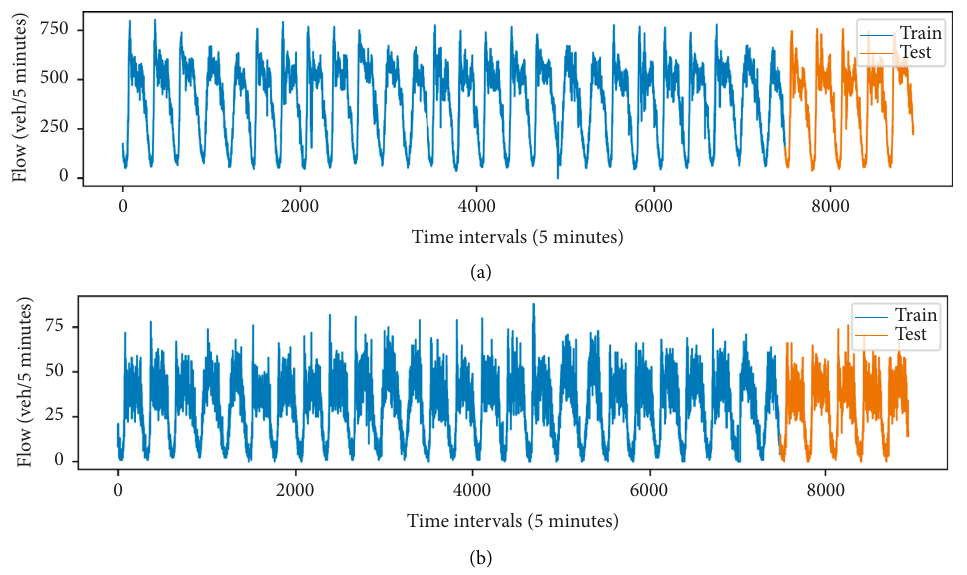
Figure 5: Training and testing datasets of (a) 717490 and (b) 718462.